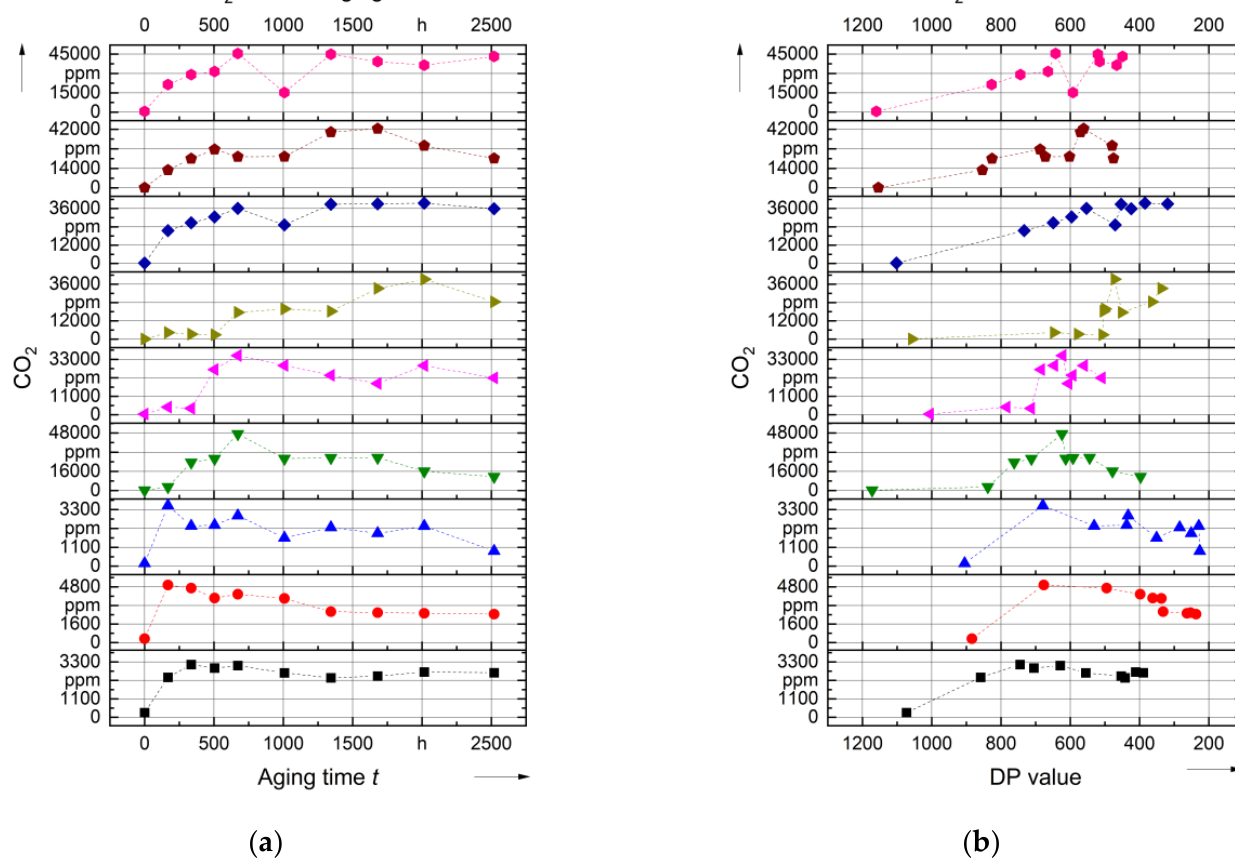
Figure 8. Change of CO 2 concentration for different sealing systems and fluids: ( a ) Change over the aging time; ( b ) Change over the DP value; the legends refer to Figure